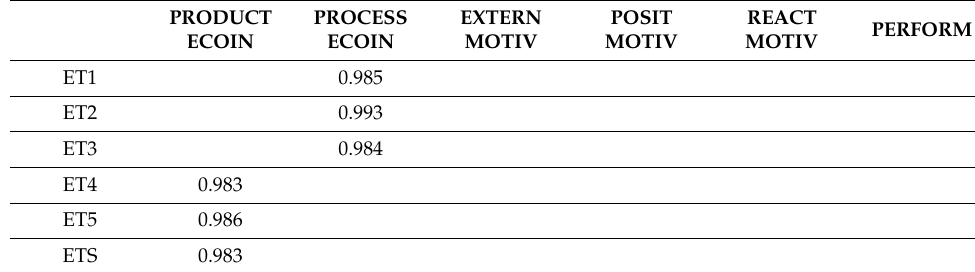
Table A3. Loads of the